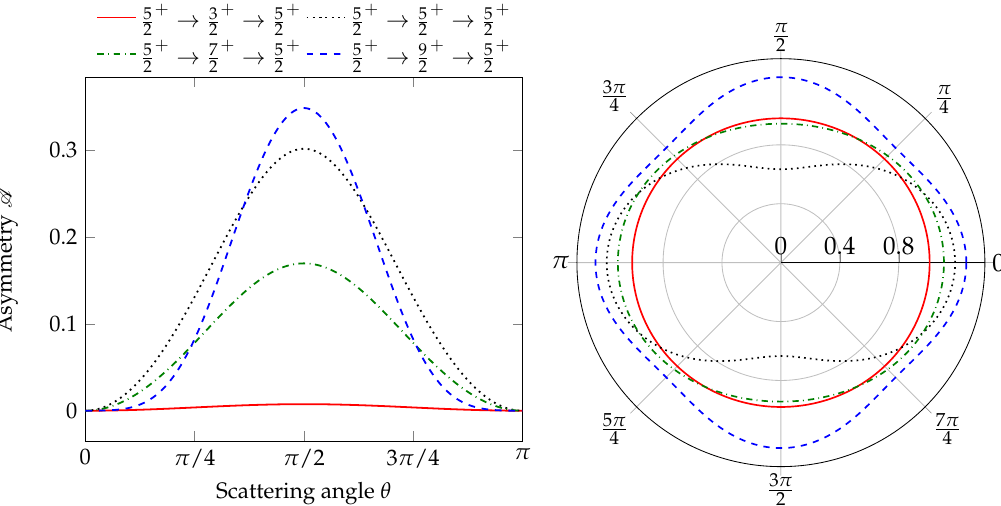
Figure 3. Ideal asymmetry ratios of possible magnetic dipole M 1 (solid, dotted, and dotted-dashed lines) and electric quadrupole E 2 (dashed line) transitions in an odd nucleus of a 5 Polar patterns of the possible dipole and quadrupole radiations ( right